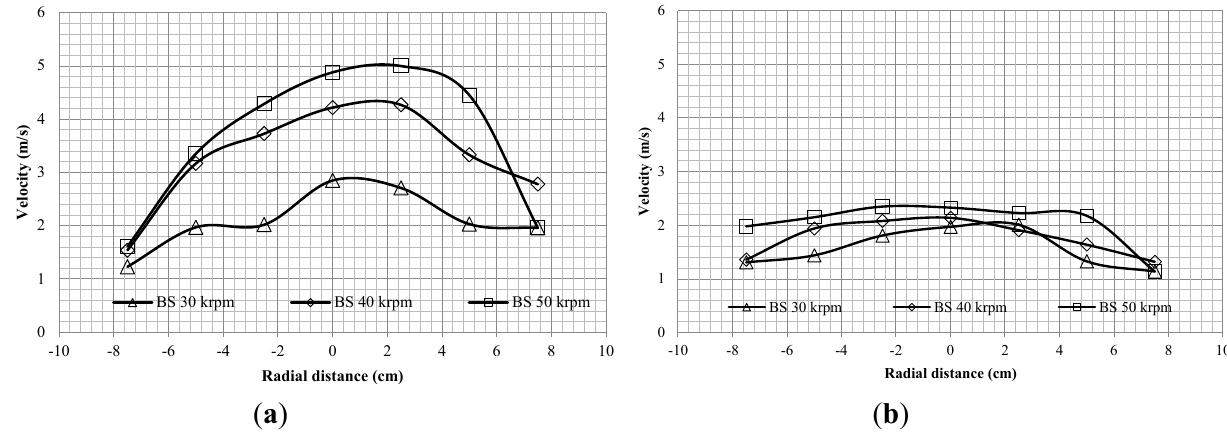
Figure 2. Particle velocity (m/s) with increasing bell speed for ( a ) 100 cm 3 /min flow rate, ( b ) 200 cm 3 /min flow